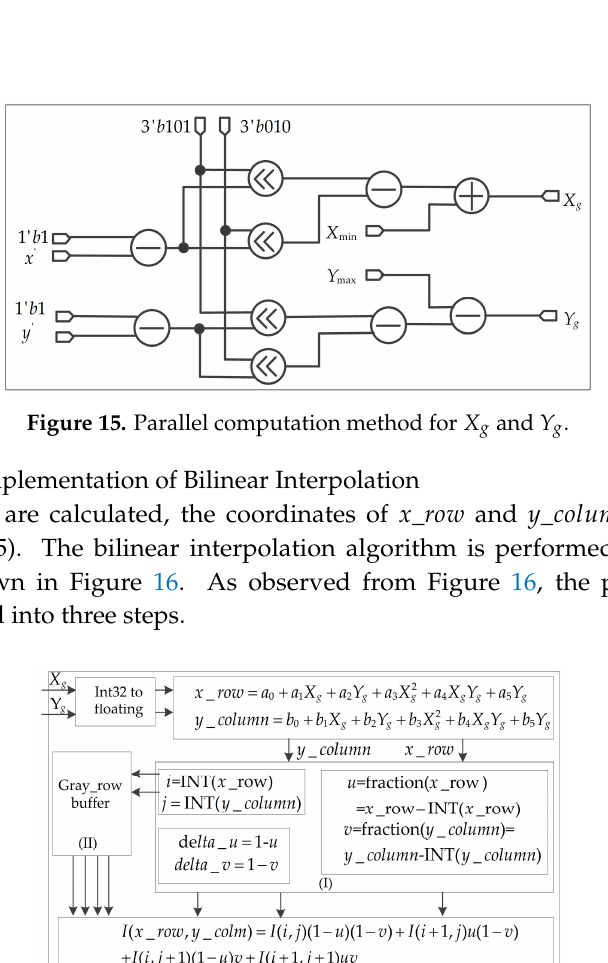
Figure 16. The diagram of bilinear interpolation.